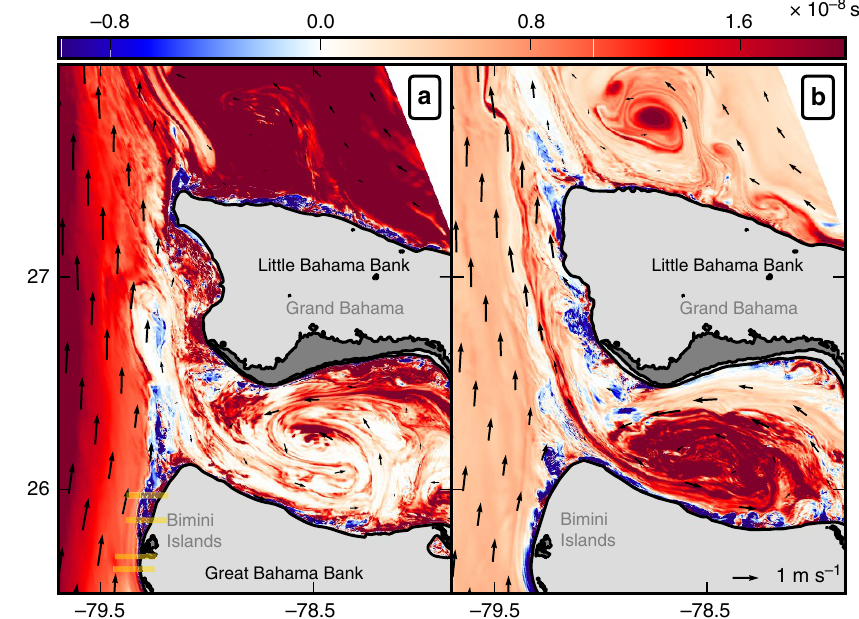
Figure 2 | Generation of negative potential vorticity and centrifugal instability. Snapshots of PV (in 10 (cid:2) 8 s (cid:2) 3 ) and velocity (vectors) at ( a ) z ¼ (cid:2) 50m and ( b ) z ¼ (cid:2) 100m. Localized regions with highly negative PV are created by the currents flowing along the topographic slopes of the Bahamas